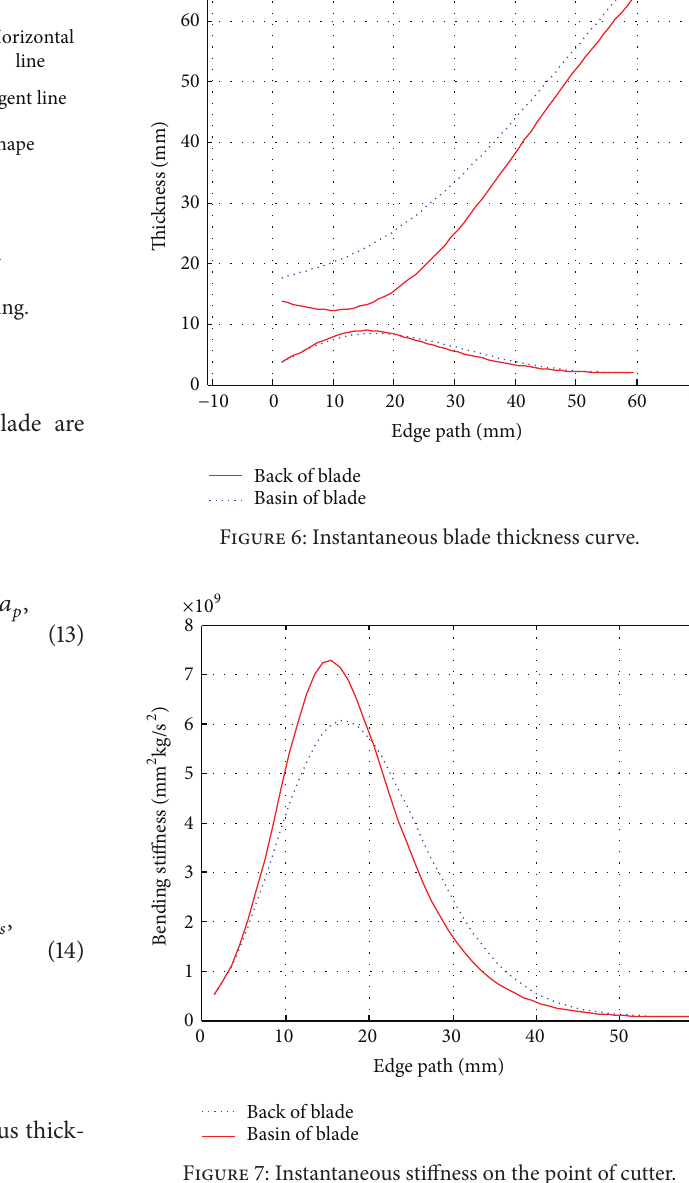
Figure 7: Instantaneous stiffness on the point of